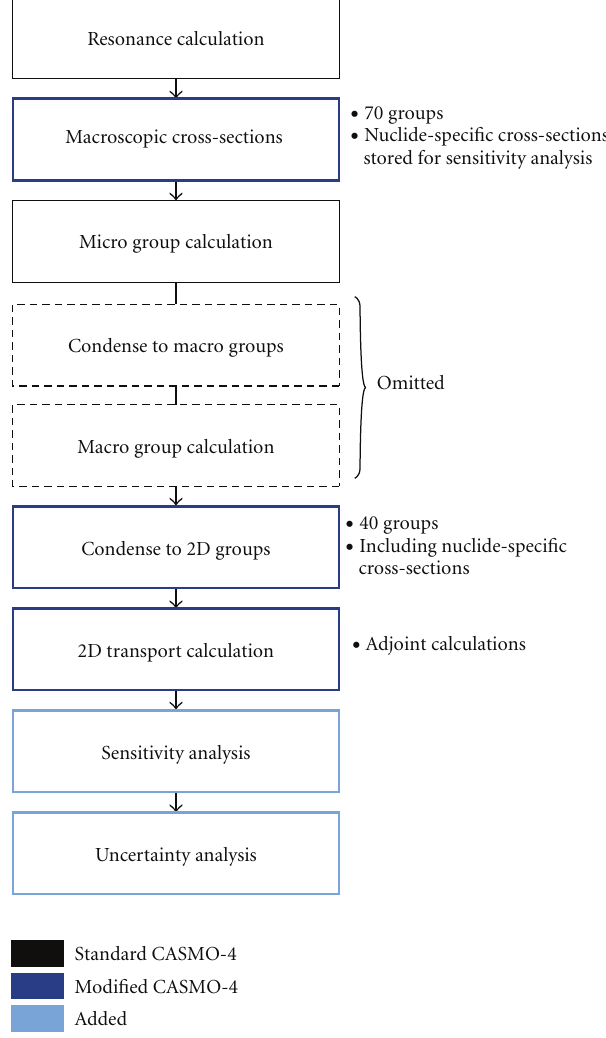
Figure 1: Outline of the CASMO-4 calculations.